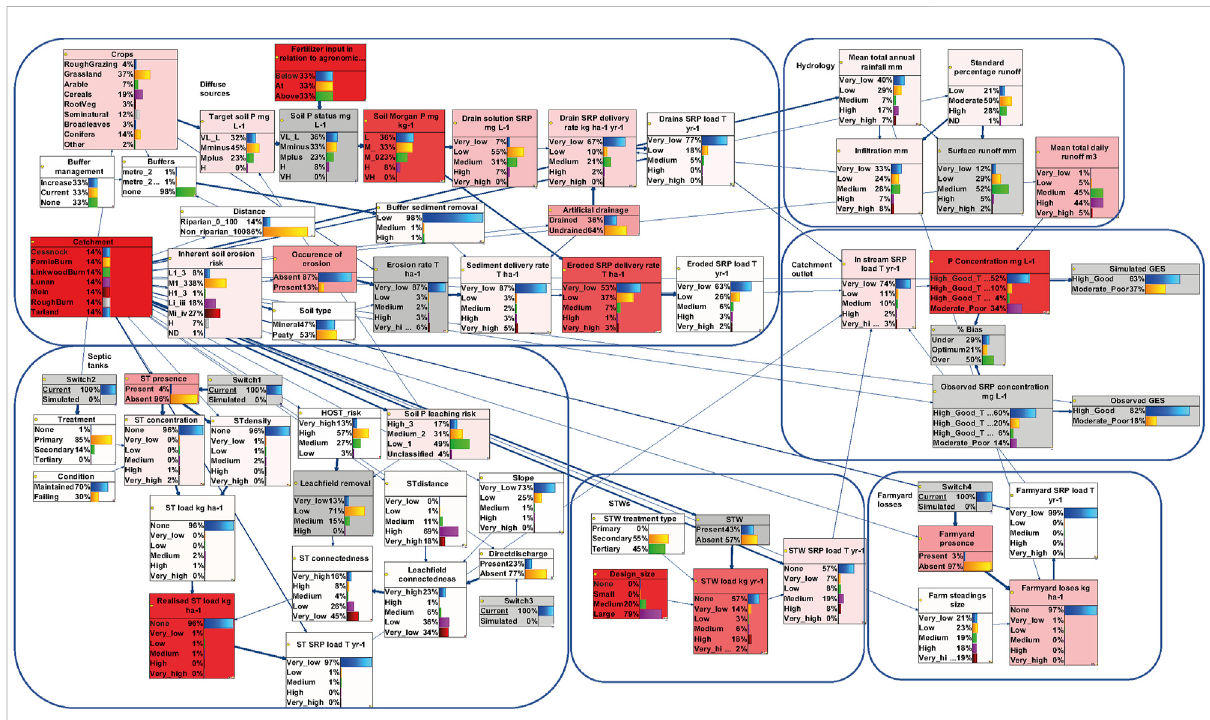
FIGURE 6 Sensitivityanalysisofthediscretisedmodelforspatialimplementation,withSRPconcentrationatthecatchmentoutlet(mgL − 1 )andlossesfrom drains, soil erosion, septic tanks, farmyards and STWs (kg ha − 1 yr − 1 ) as target nodes. Deeper red indicates more sensitive variables and thicker lines greater strength of in fl